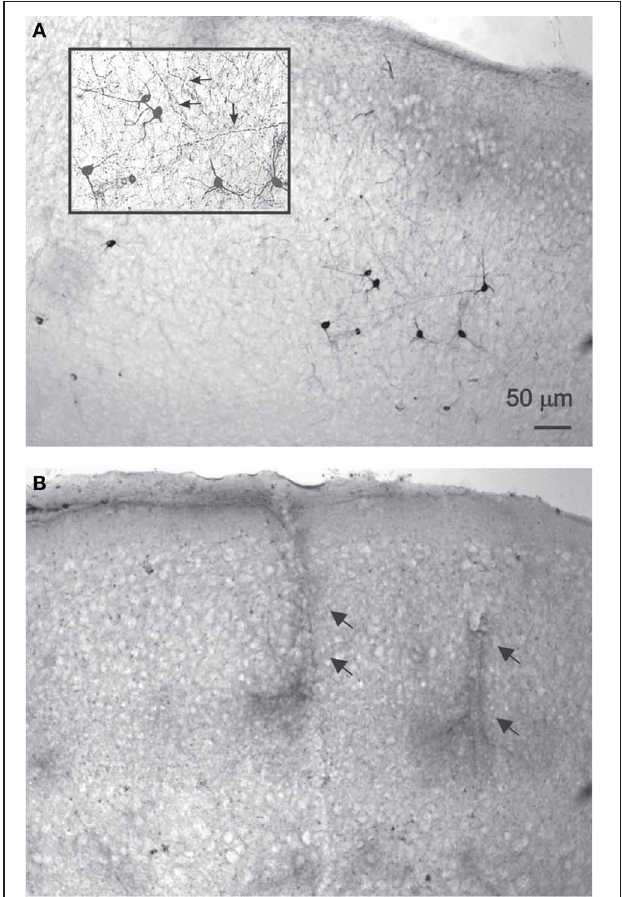
FIGURE 2 | NADPH-d staining is reduced following DAF-2DA incubation and illumination. (A) Control, untreated sections display multiple darkly stained neurons. In the inset, additional magnification highlighting the network of stained axons (arrows). (B ) Neocortical section which had been treated by DAF-2DA and illumination. The histochemical reaction has been extended for several hours. No neurons are seen, but note darkly stained